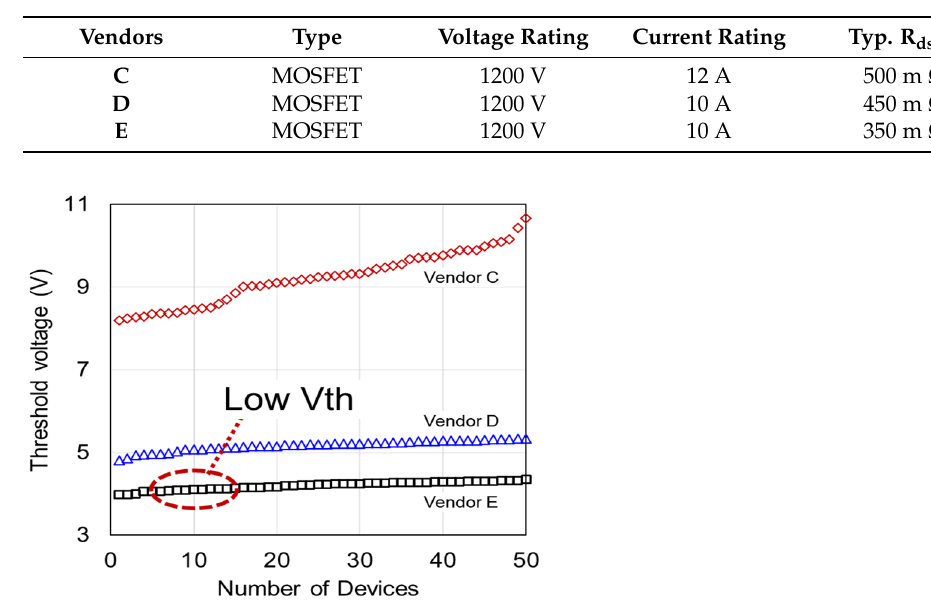
Table 1. Devices under Tests (DUTs).